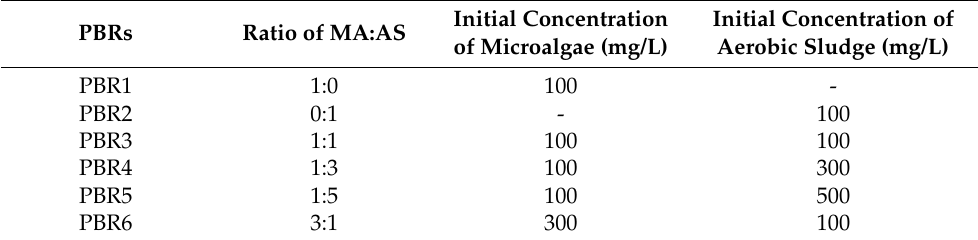
Table 1. Characteristics of the initial inoculation concentration of